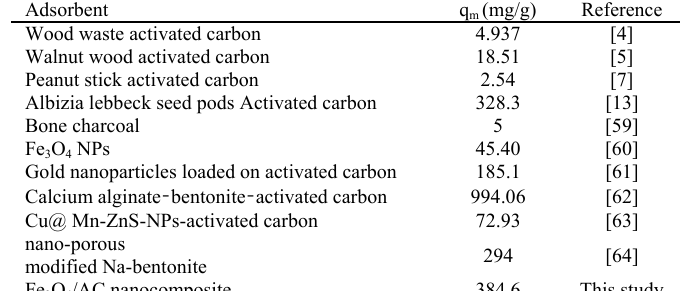
Table 7. Comparison of the maximum adsorption capacities of MB dye onto various adsorbents